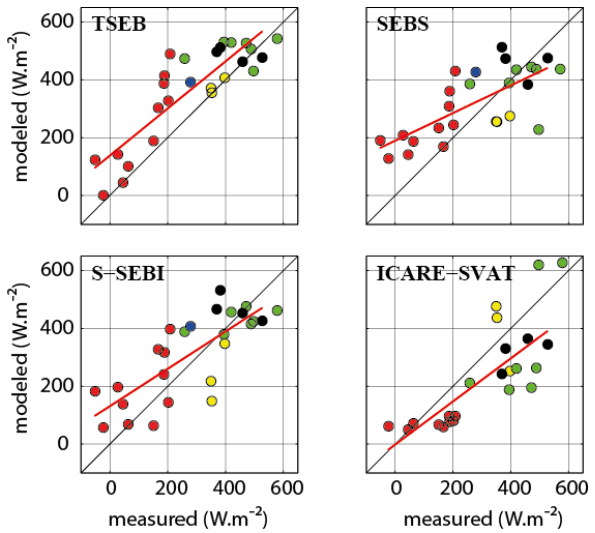
Fig. 8. Simulated versus measured latent heat flux λE for every station at ASTER overpass dates. Color code: red: LAI < 0.4; yellow: 0.4 ≤ LAI < 0.8; green: 0.8 ≤ LAI < 1.2; navy- blue: 1.2 ≤ LAI < 2.0; black: LAI ≥ 2.0.